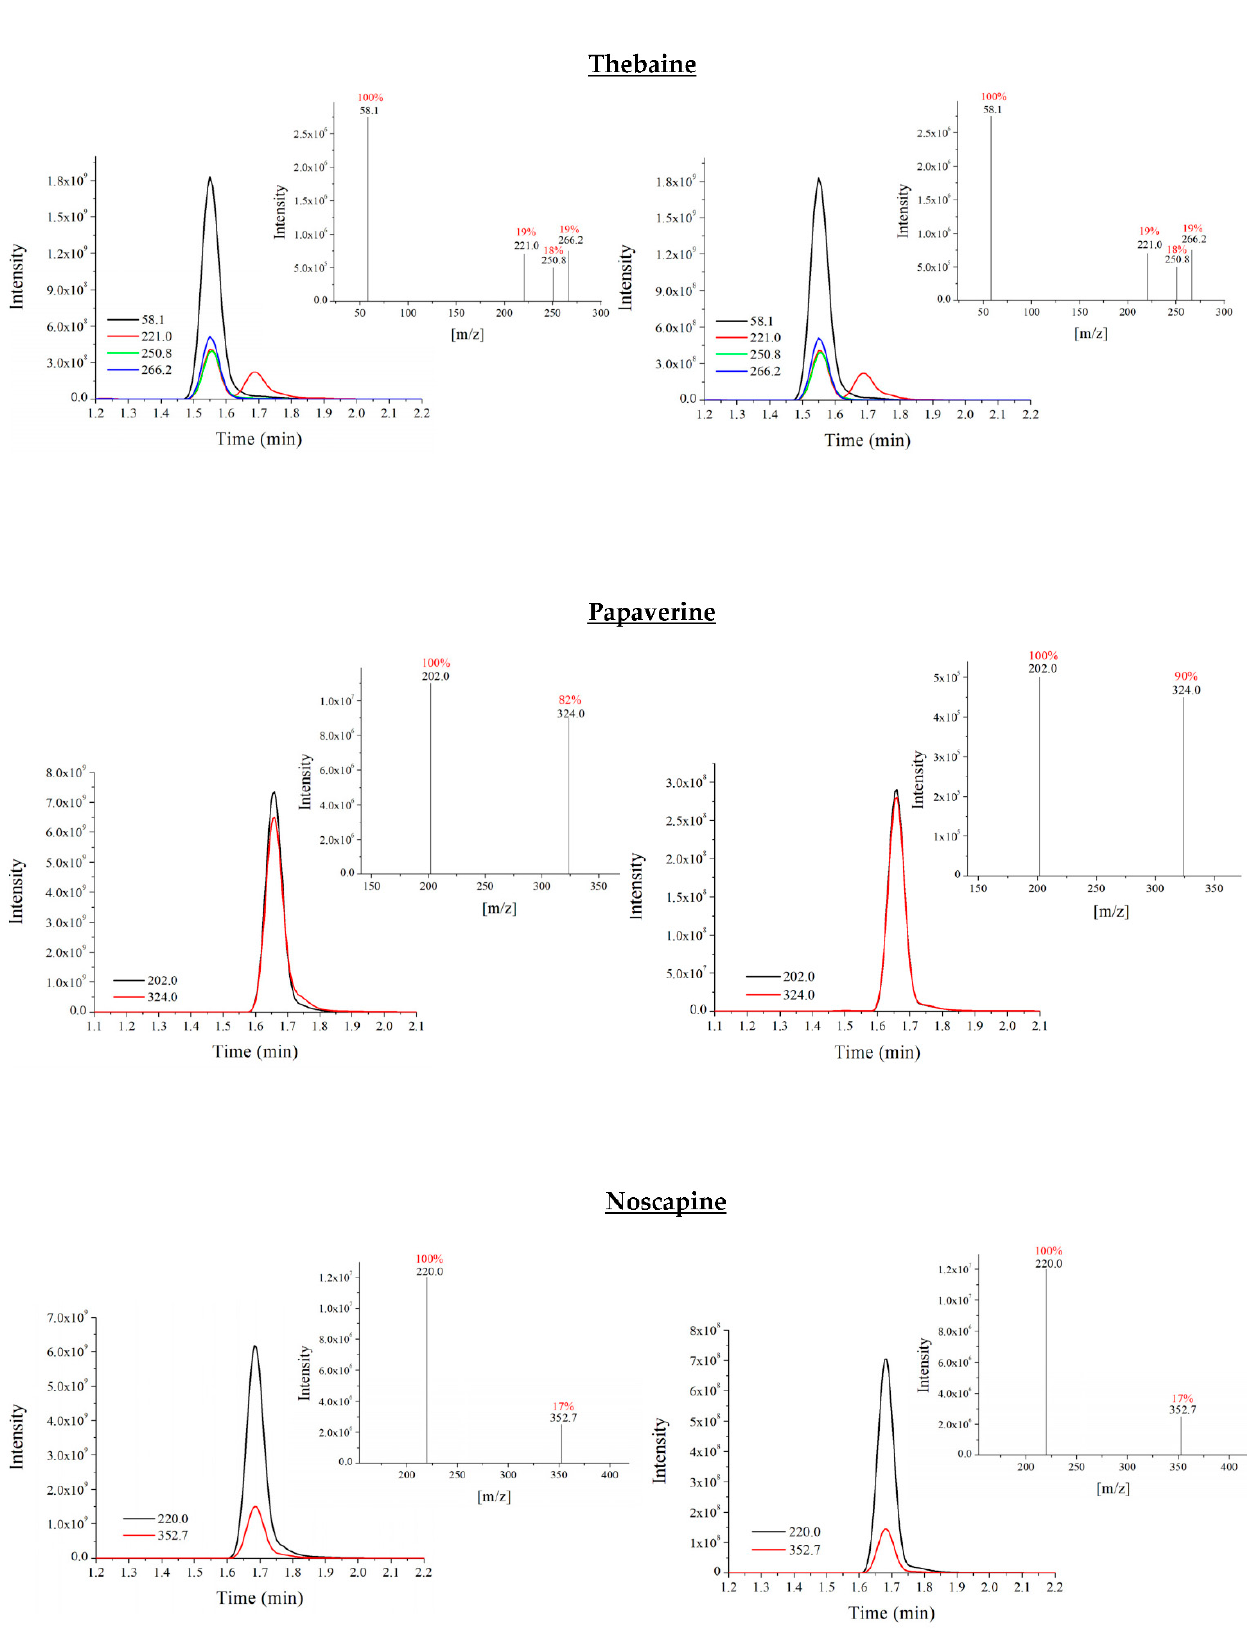
Figure 5. Comparison between the extracted ions chromatograms and the intensity of fragment ions mass spectrum (relative abundance (%) in colour red) obtained for each of the compounds in a standard solution mixture 1 mg/L ( left ) with respect to a poppy seed sample ( right ).